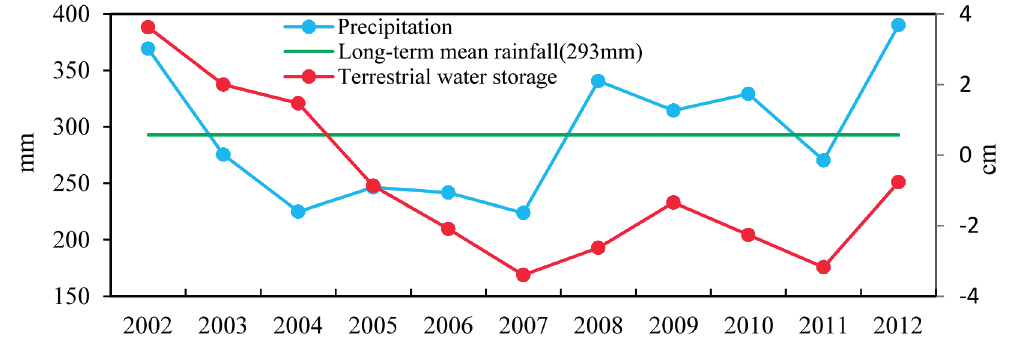
Figure 6. Annual precipitation and water storage changes series from 2002 to